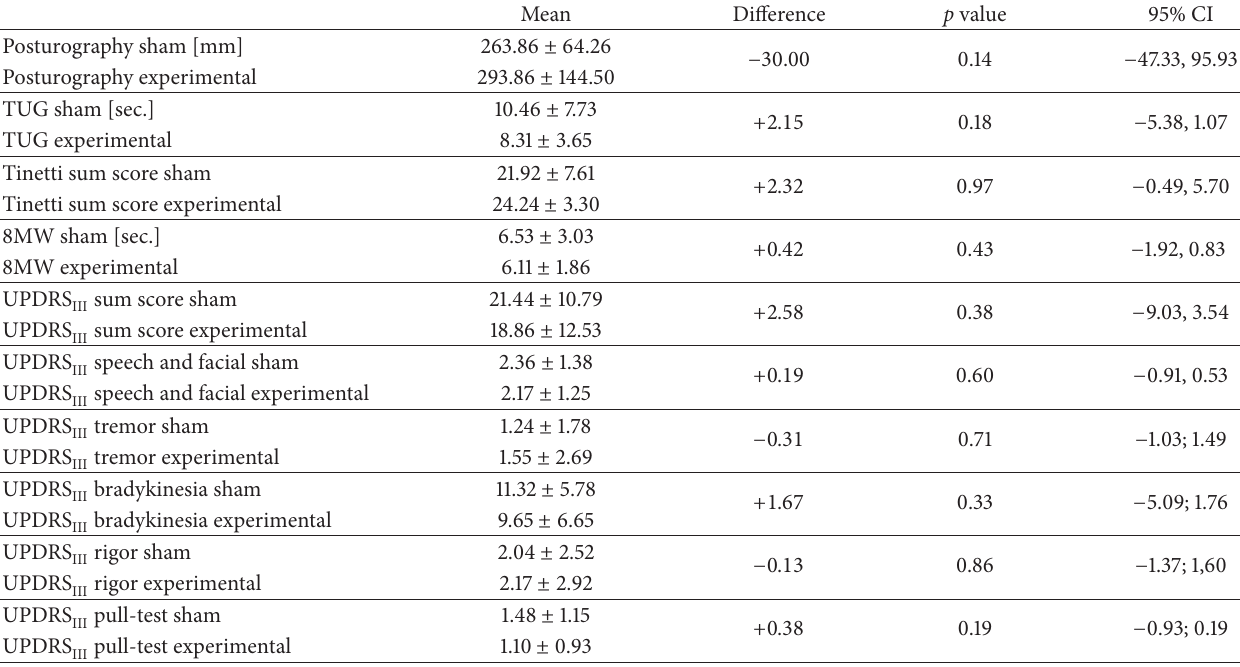
Table 2: Effect of whole body vibration after treatment (between-group comparison).